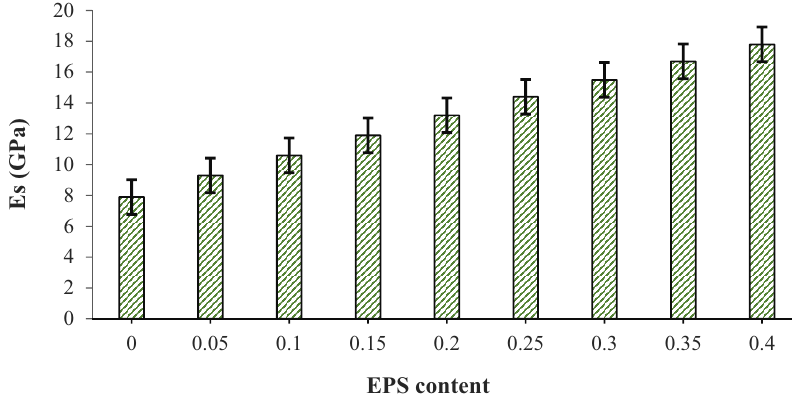
Figure 3: The elastic modulus of EPS - AC versus the EPS